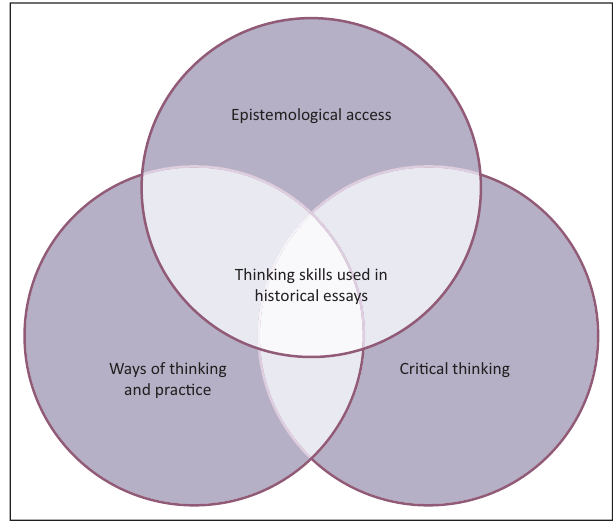
FIGURE 1: Overlapping concepts informing historical thinking in